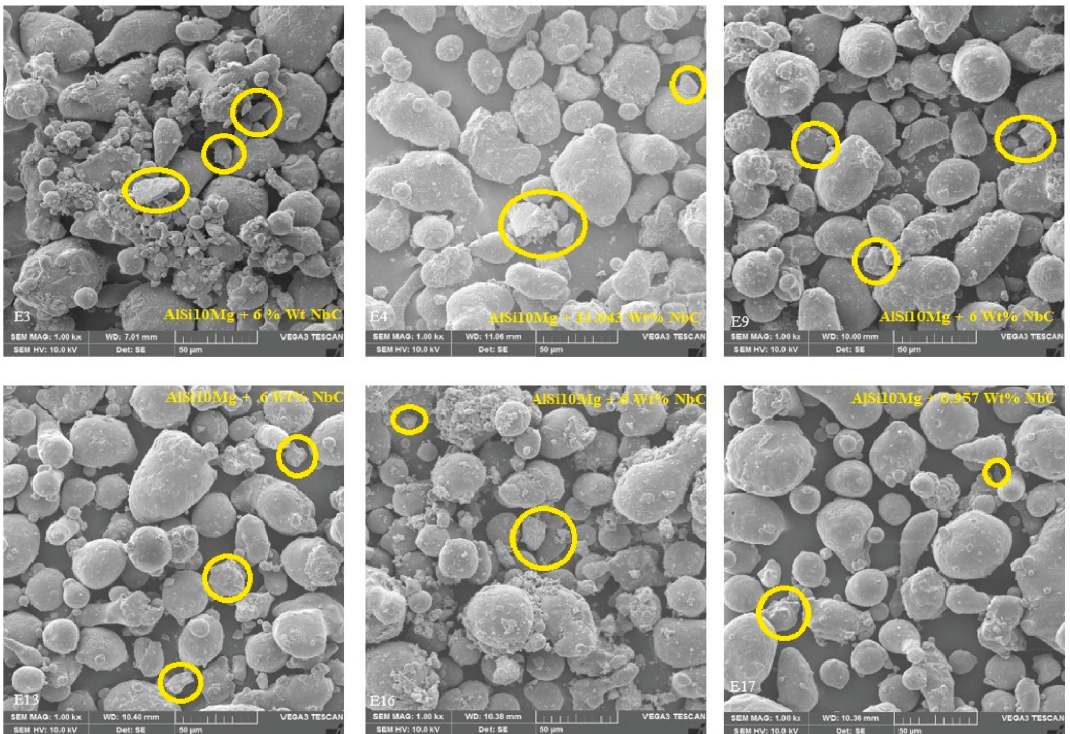
Figure 4: SEM images of extreme-based